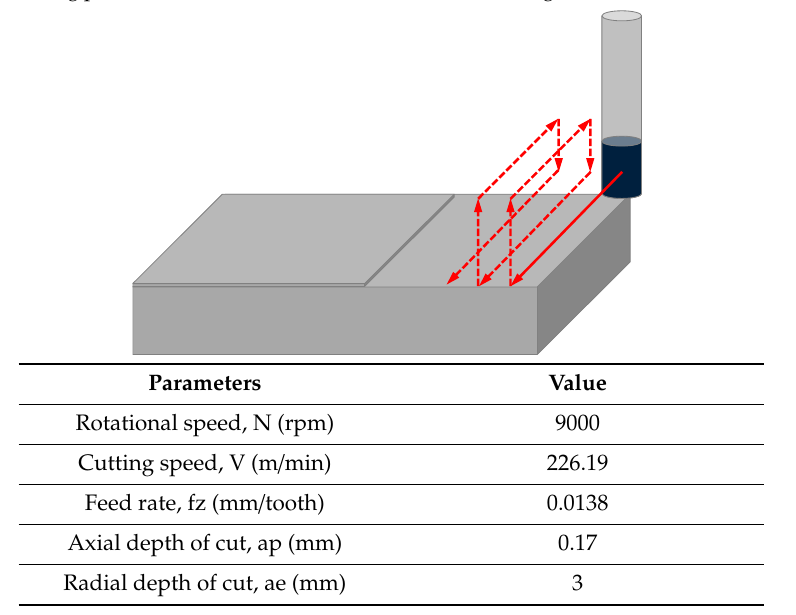
Table 1. The cutting parameters of the coated end mills for machining SUS316L austenitic stainless steel.